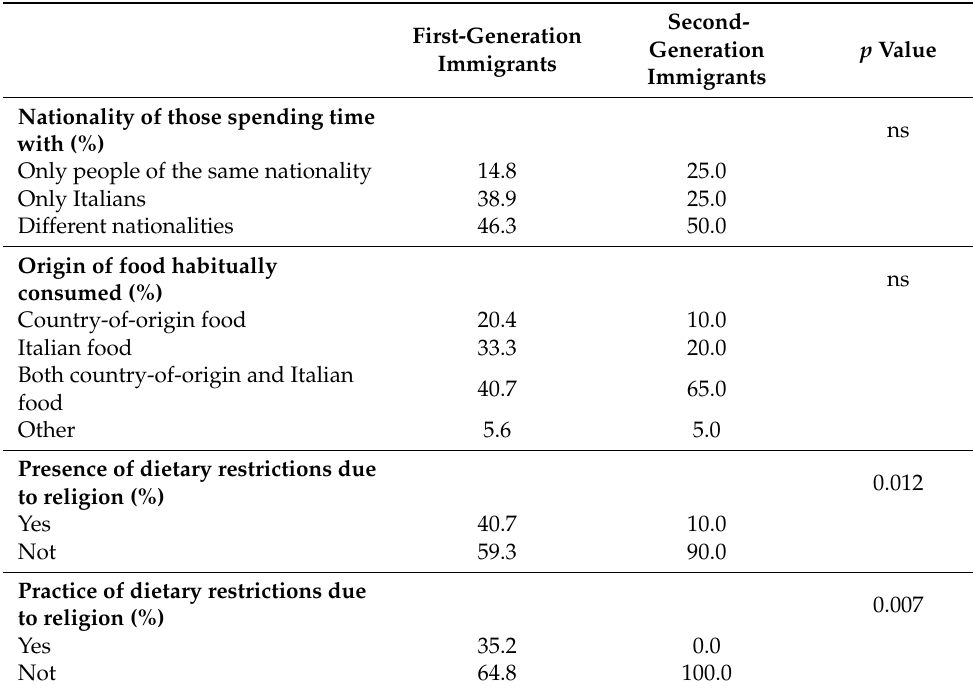
Table 5. Nationality of people volunteers spend time with, origin of food habitually consumed, presence of religious dietary restrictions and their practice by migration